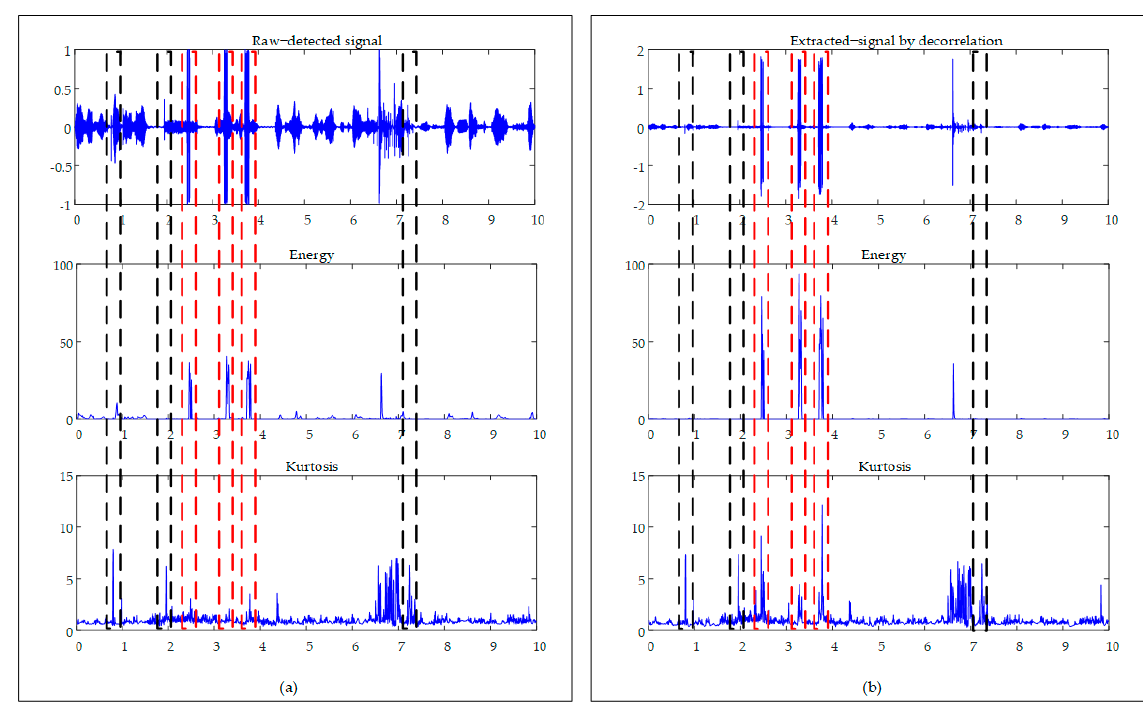
Figure 6. Laser captured speech signal, with the average short-time energy and kurtosis for ( a ) the raw-detected signal and ( b ) the extracted-signal by decorrelation.